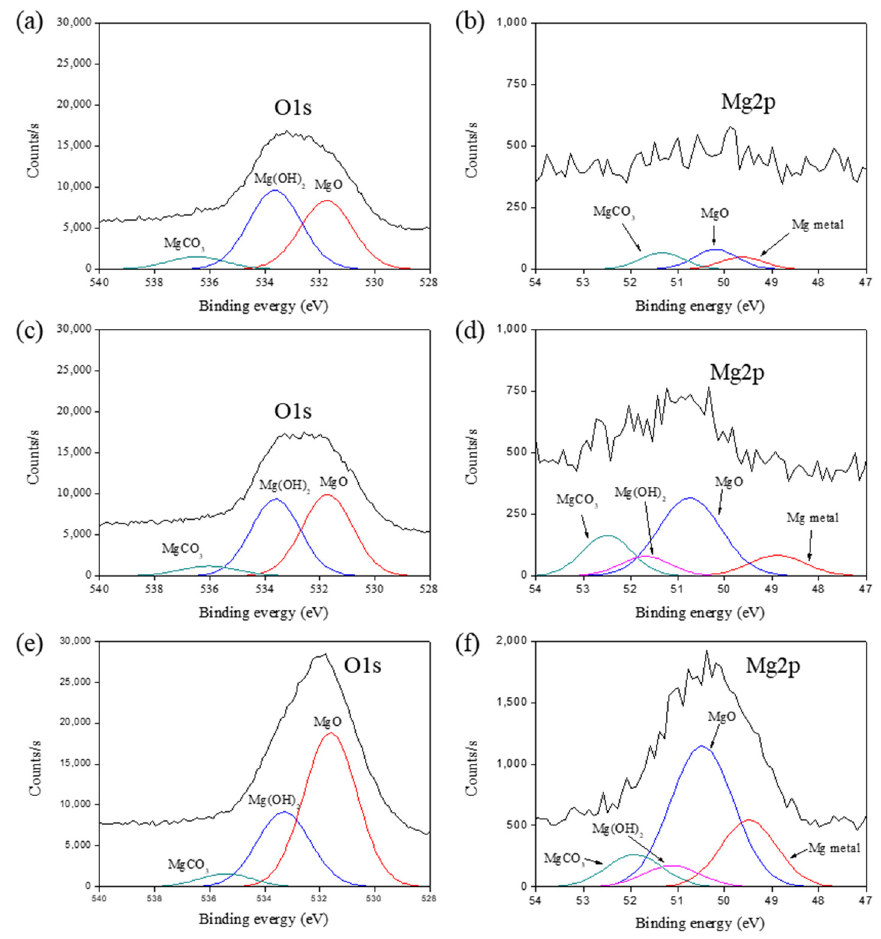
Figure 2. High-resolution peaks of ( a , b ) 1-MgO-AC, ( c , d ) 2-MgO-AC, and ( e , f ) 5-MgO-AC. Table 1. Chemical compositions and textural properties of the MgO-coated AC samples. Atomic Percentage (at.%) Specimens